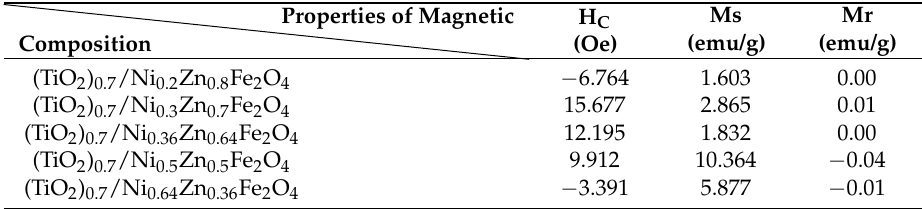
Table 4. The magnetic property of [Ni x Zn 1 − x ]Fe 2 O 4 when cladded with TiO 2 .